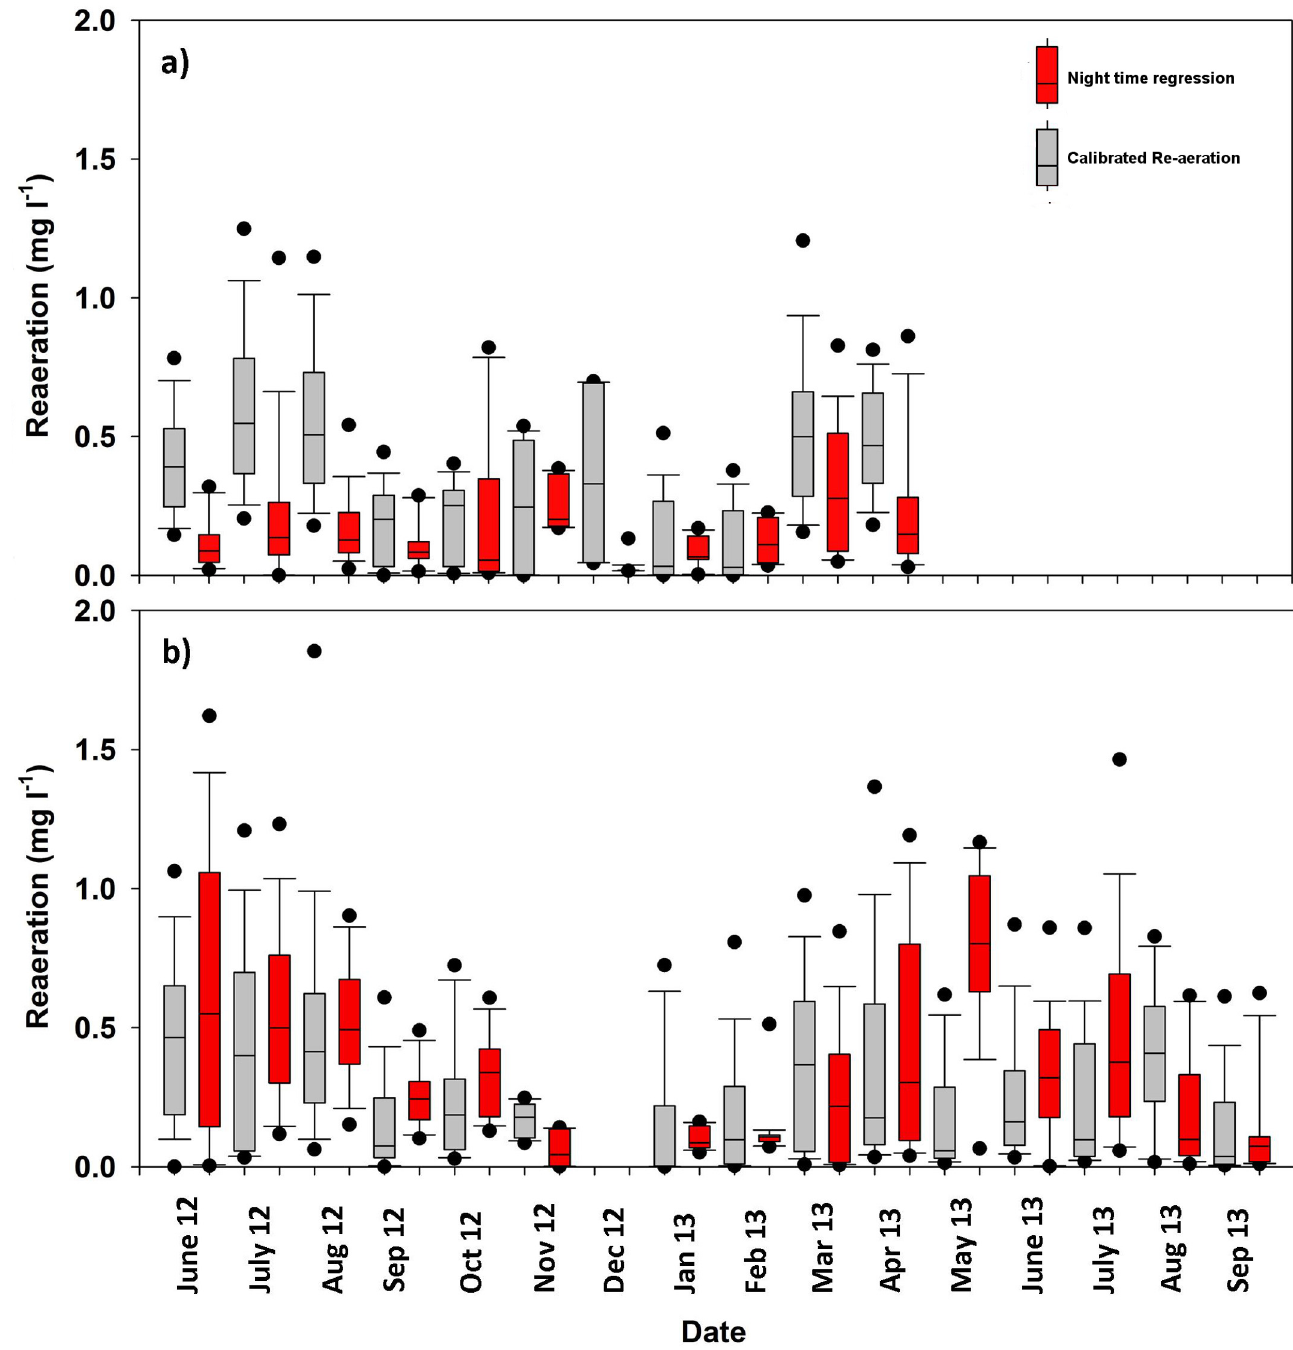
Fig 6. Monthly box plots comparing hourly re-aeration calculated using the calibrated re-aeration coefficient and the re-aeration coefficient calculated using the night time regression method [63] for the upper catchment (a) and lower catchment